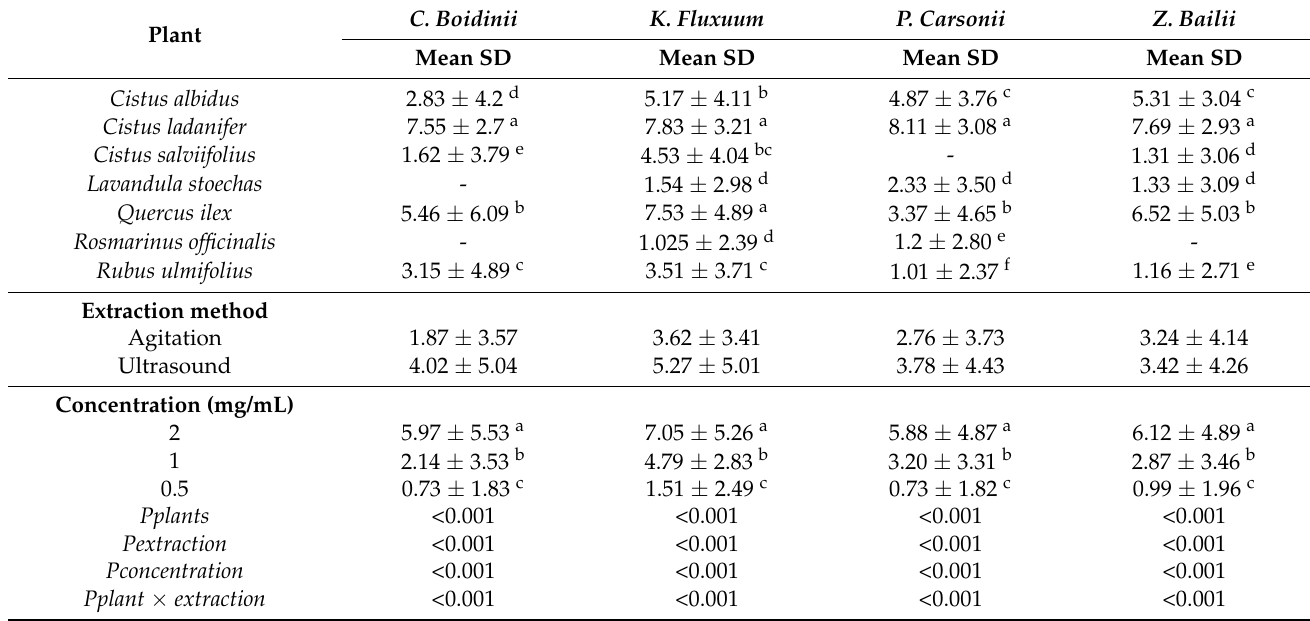
Table 4. Diameter of inhibition zones in mm of different concentrations of plant extracts tested that showed activity against